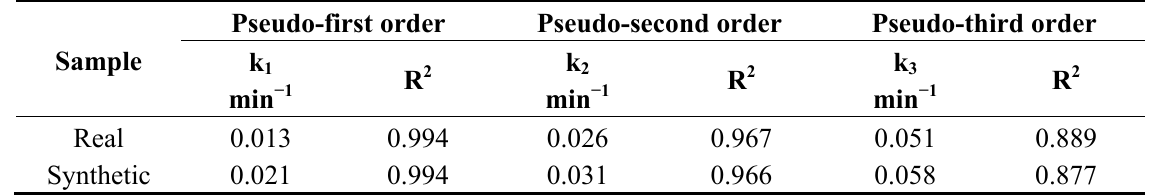
Table 1. Kinetic constants for the decolorization of real and synthetic effluent with COF at 25 °C.